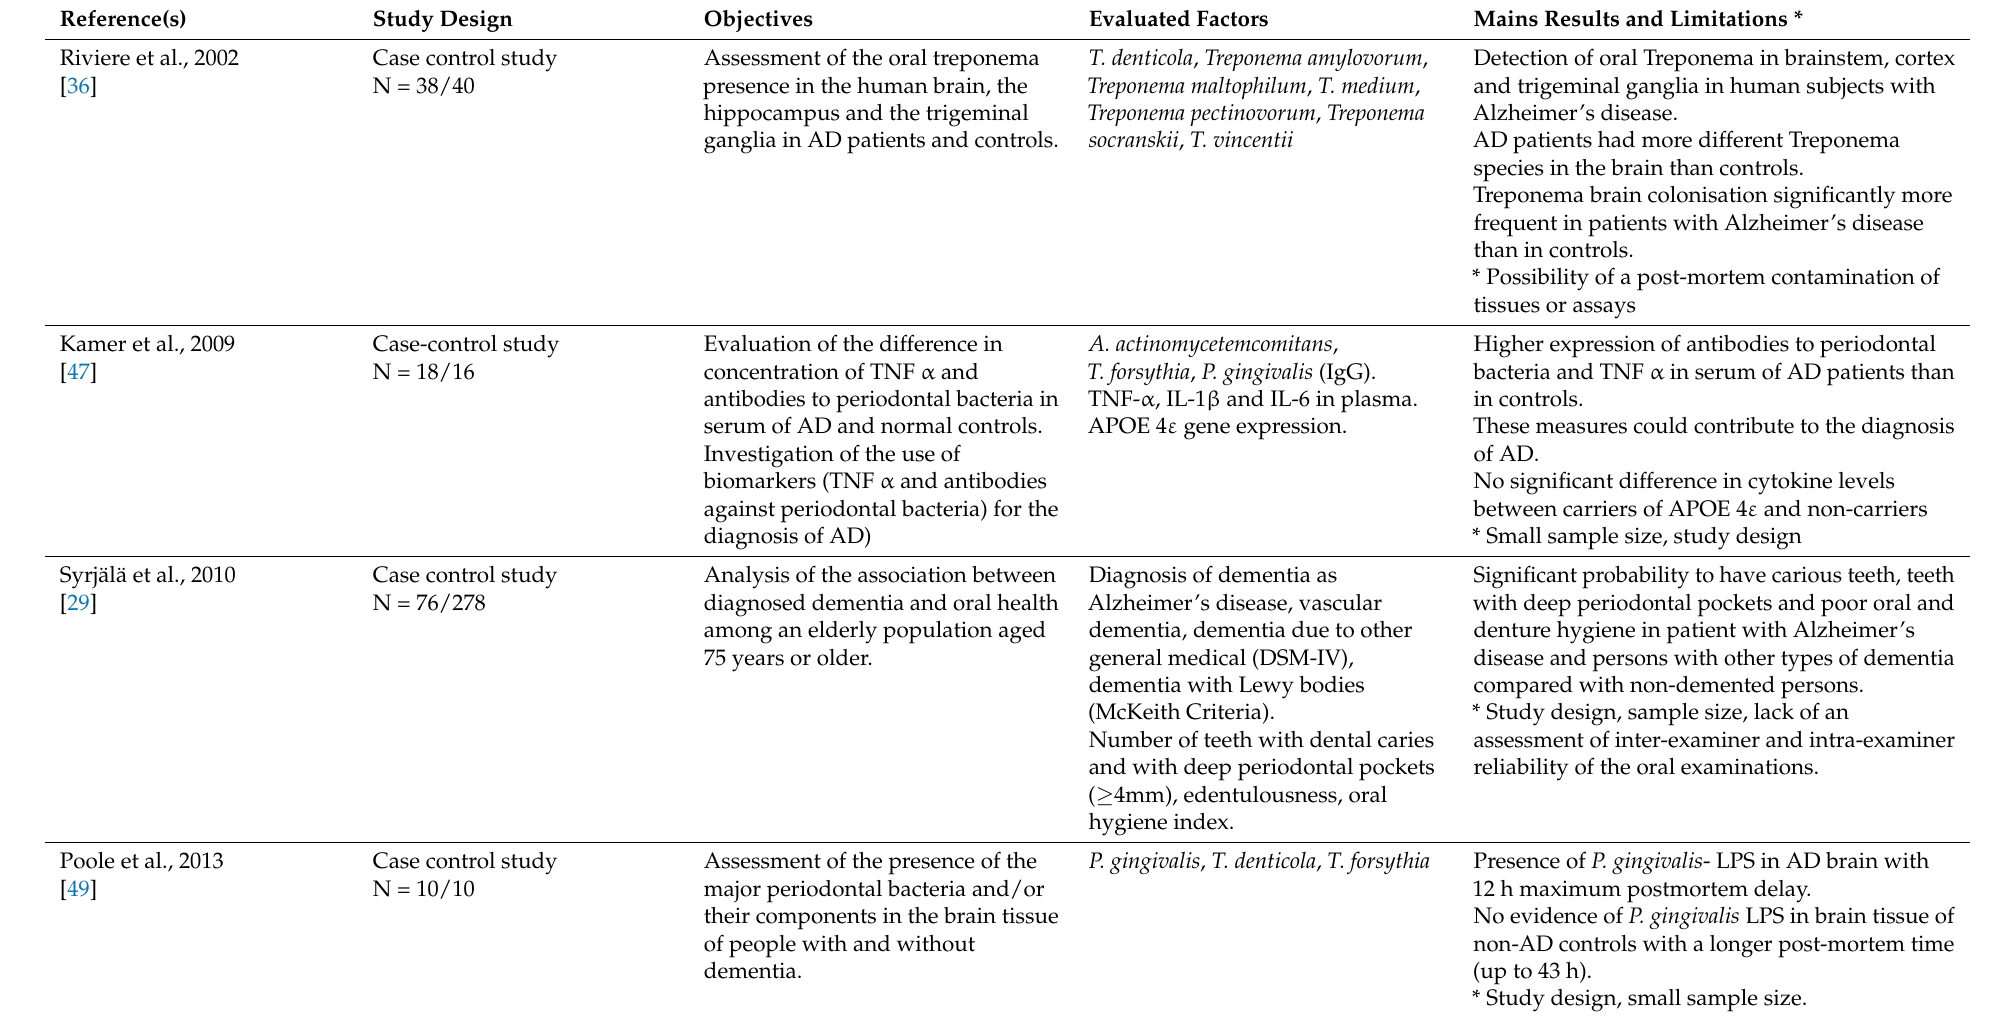
Table 1. Analysis of selected